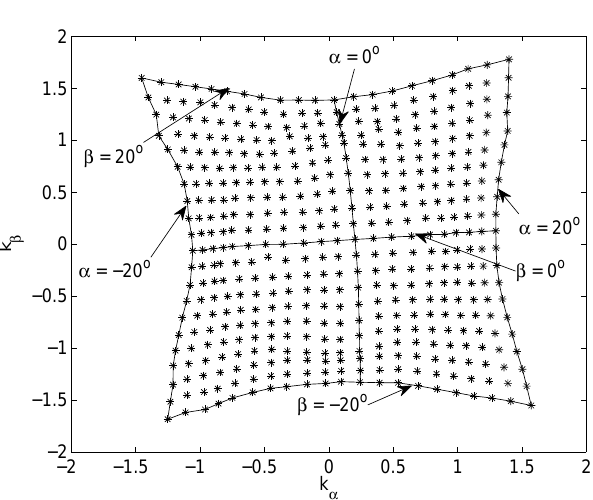
Fig. 6. Standard deviation of the pressure ports P static in front of the ring of the ISM probe during a wind-tunnel calibration. Angle of attack 10 ◦ , angle of sideslip shifted from − 20 to 20 ◦ .